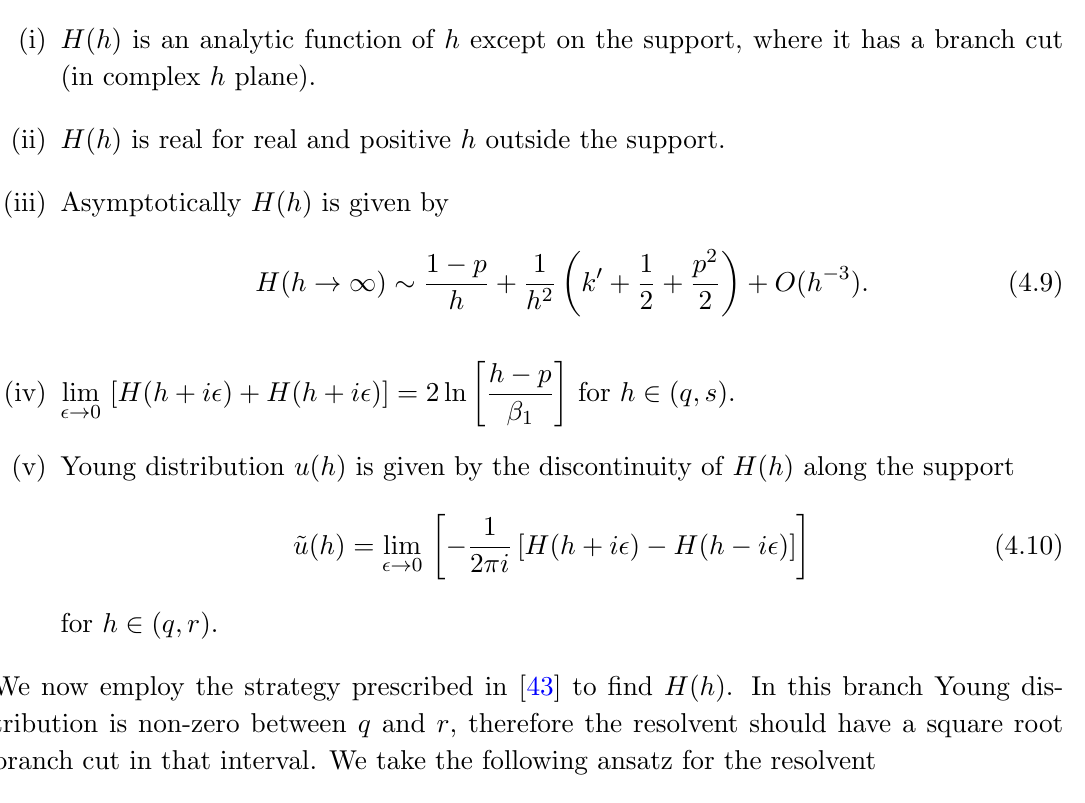
Figure 7 . A typical Young diagram for upper-cap